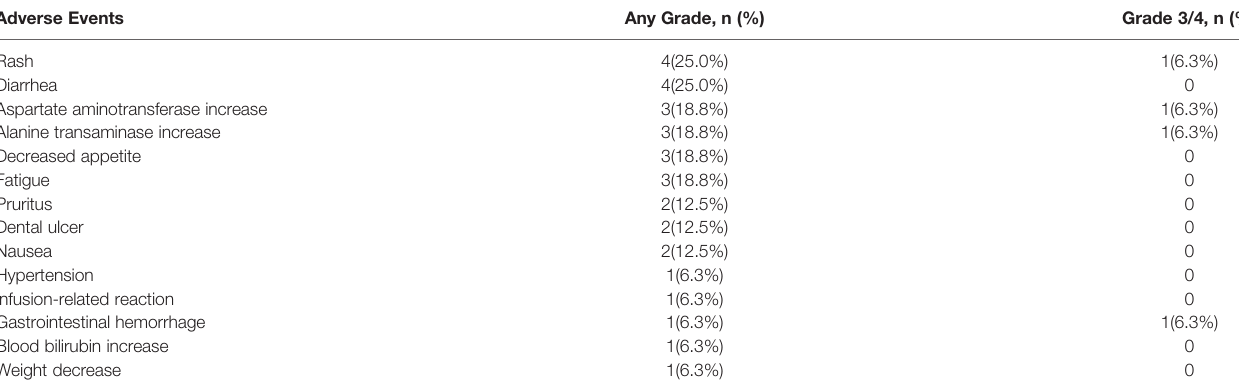
TABLE 4 | Treatment Related Adverse Events.